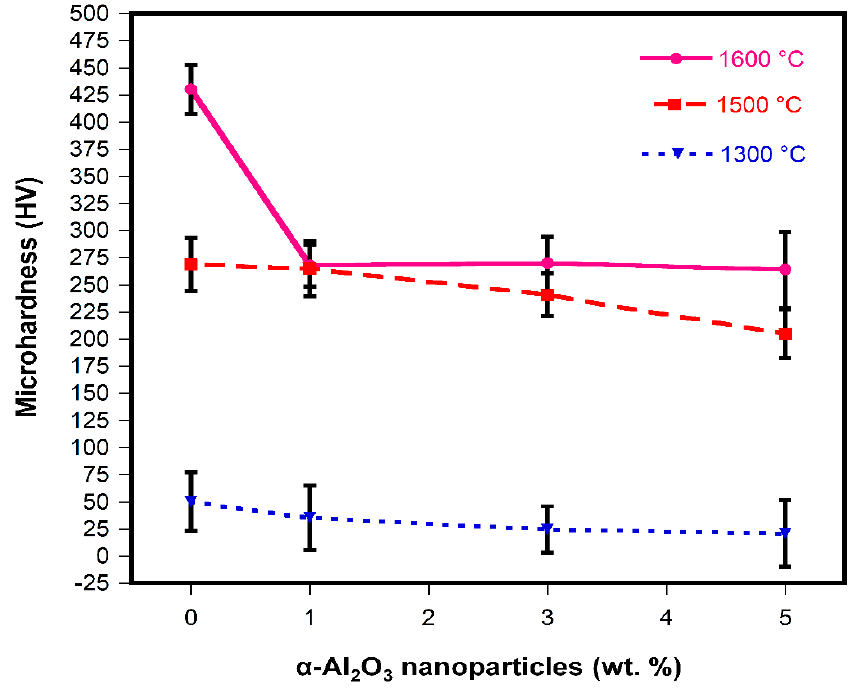
Figure 10. Variation of microhardness with α -Al 2 O 3 nanoparticle additions.